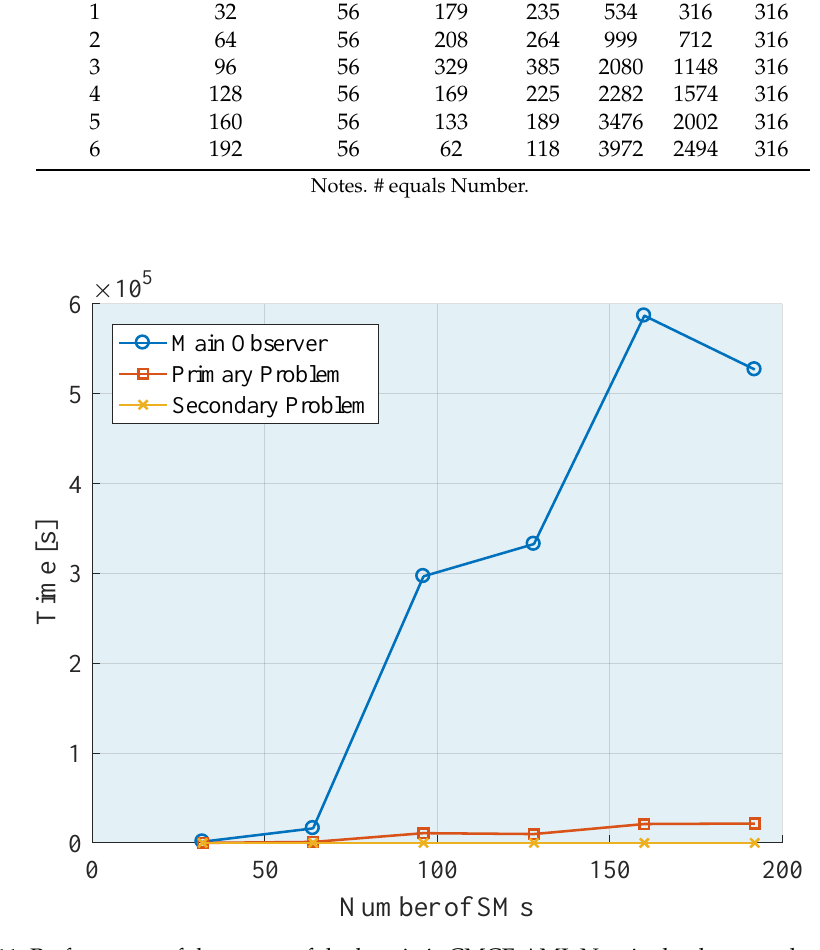
Figure 11. Performance of the stages of the heuristic CMCF-AMI. Nominal values employed for this figure are based on